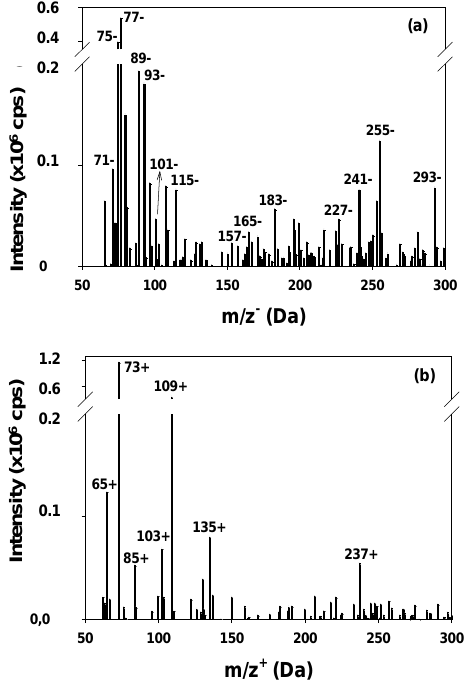
Figure 6 : Mass spectra (in the negative mode (a) and in the positive mode (b)) differences 46 between “H 2 O 2 + h  ” samples and “control” samples which show the ions formed during the 47 aqueous phase processing (experiment 1), measured with APCI-MS by direct infusion of 48 Fig. 6. Mass spectra (in the negative mode a and in the positive mode b ) differences between “H 2 O 2 + hν ” samples and “control” samples which show the ions formed during the aqueous phase pro- cessing (experiment 1), measured with APCI-MS by direct infusion of aqueous